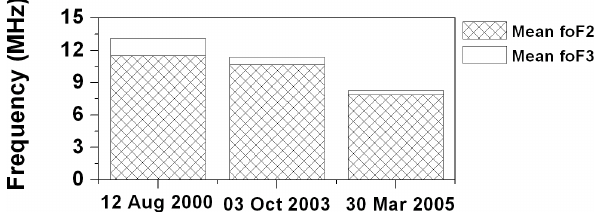
Fig. 1b. Histogram illustrating the mean critical frequencies of F2 (averaged between 08:00–16:00IST-shaded) and F3 (open) layers at Trivandrum for the days shown in Fig. 1a.